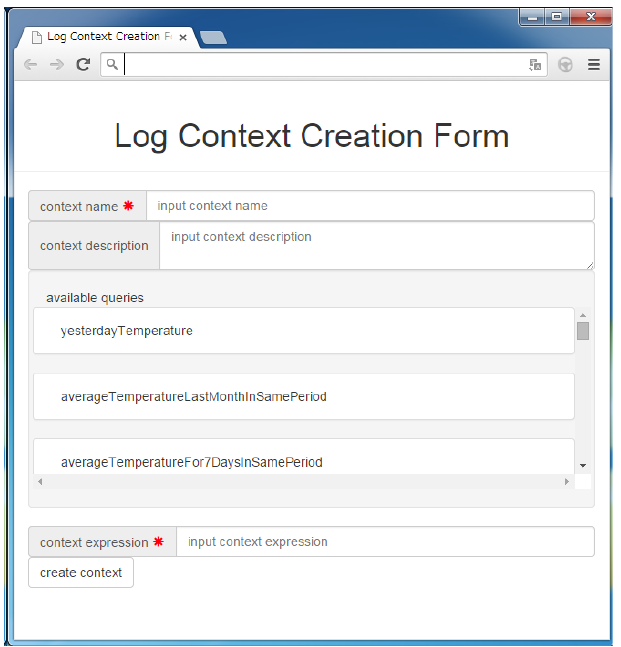
Figure 6. Log context creation